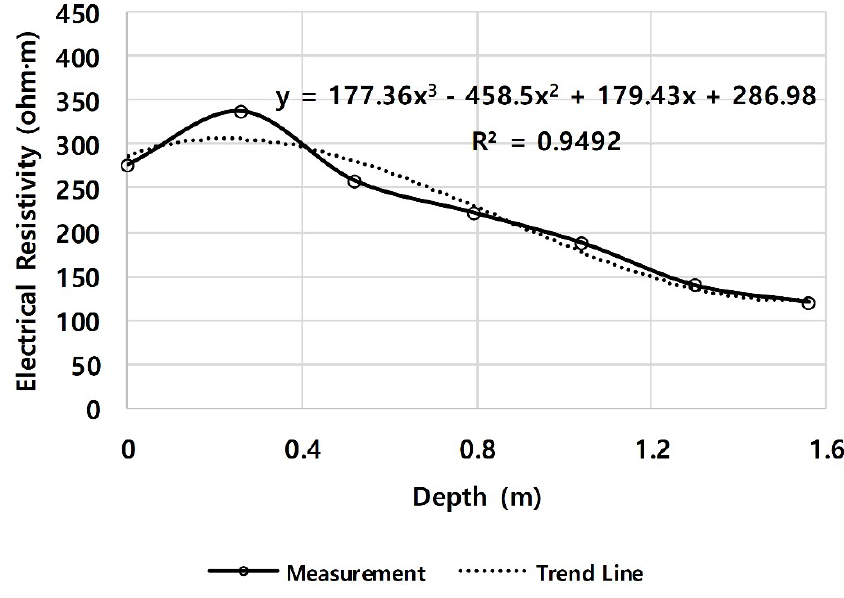
Figure 13. ER according to the depth measured at the natural ground (Section 1).